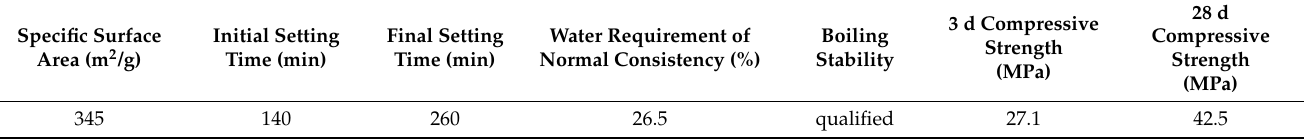
Table 1. Physical properties of the cement.